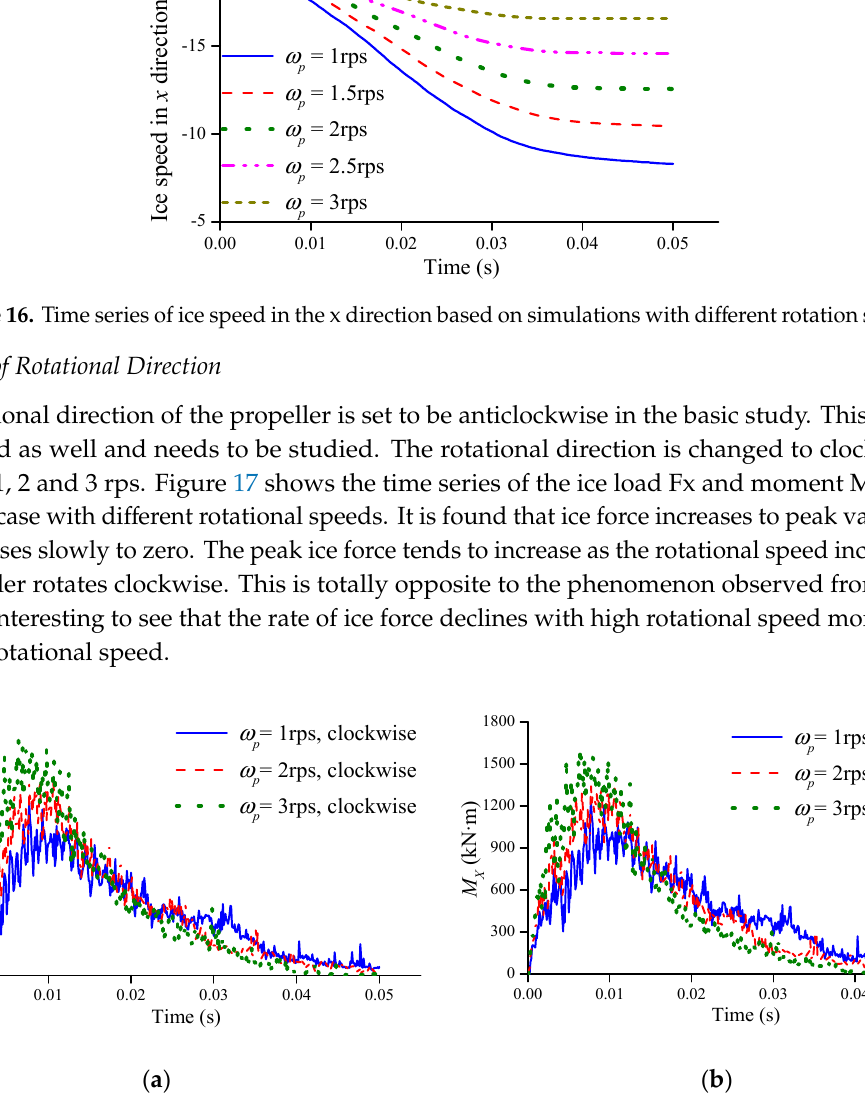
Figure 17. Time series of ice load Fx and Mx based on simulations with different rotation speeds for clockwise rotation. ( a ) The Fx with different rotation speed. ( b ) The Mx with different rotation speeds.